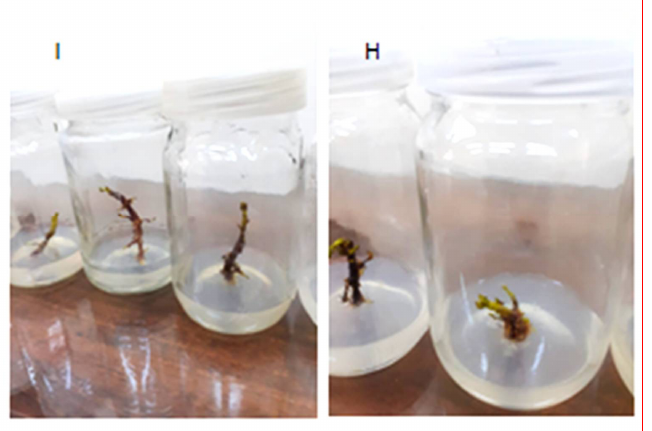
Figure 1. Sprouts of PVY infected potato explants ( Solanum tuberosum L.) cv. Spunta ( I ) showing shoot regeneration on MS medium supplemented with different concentrations of Chitosan (CS-NPs). Healthy explants ( H ).